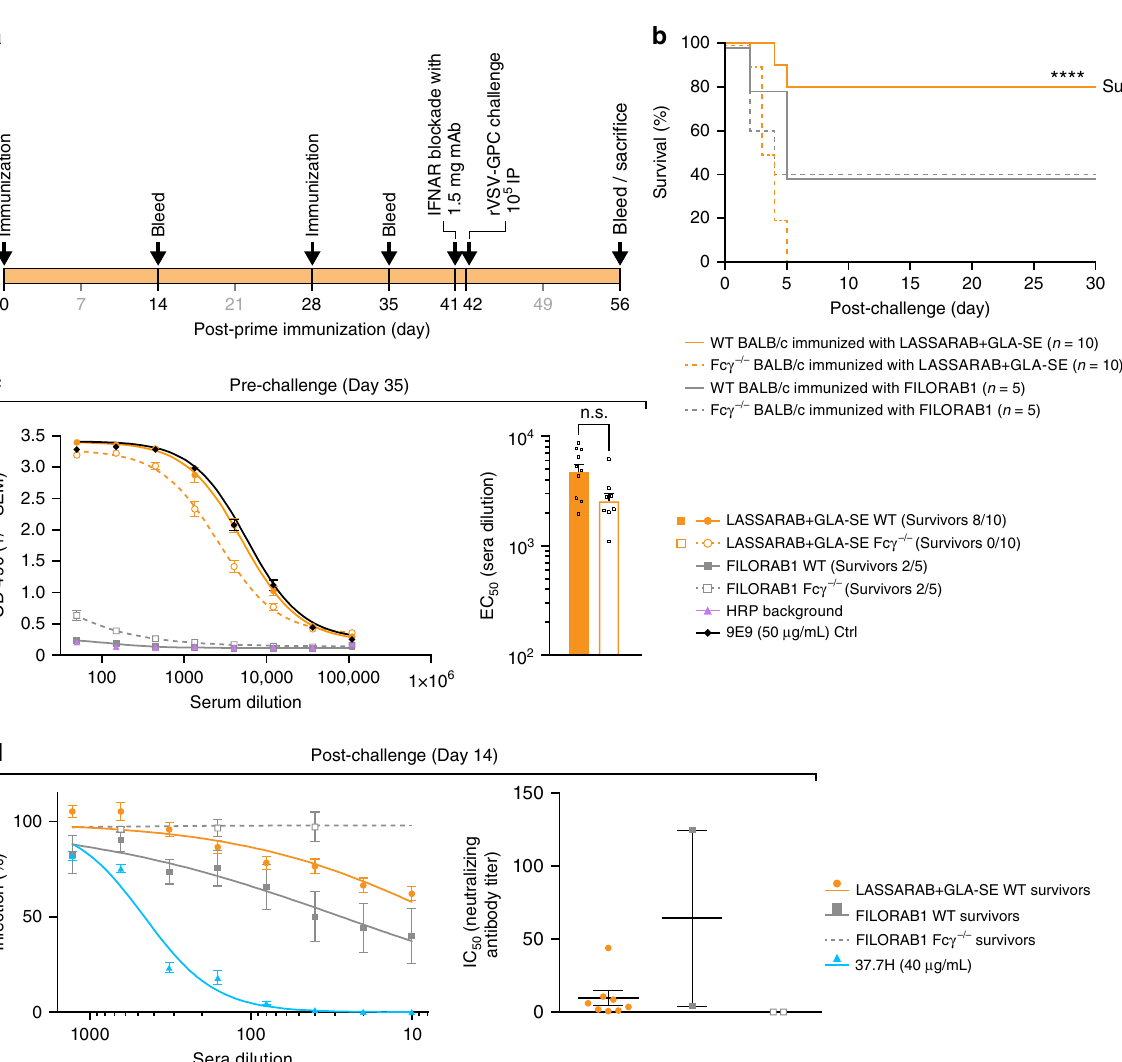
Fig. 8 Evaluation of in vivo relevance of non-NAbs LASV GPC speci fi c antibodies induced by LASSARAB + GLA-SE vaccination. a 8- to 10-week-old Balb/c (WT) or Balb/c with Fc γ chain KO (Fc γ − / − ) female mice were immunized with 10 µ g of inactivated particles of either LASSARAB or FILORAB1 (mock control) on day 0 and boosted on day 28. All four groups in total were adjuvanted with 5 µ g of GLA in a 2% SE with each vaccination. One day before exposure (day 41) animals were injected with 1.25 mg of anti-Ifnar mAb (MAR1-5A3, Leinco technologies) through intra-peritoneal injection (IP). On day 42, mice were exposed to 10 4 rVSV-GPC virus IP and general health (weights and clinical observation) was recorded until endpoint criteria were reached or end of study (supplemental). b Survival curves post-exposure of rVSV-GPC. Signi fi cance is compared between the WT LASSARAB vaccinated and the Fc γ − / − vaccinated using the log-rank (Mantel – Cox) test. c Pre-exposure total IgG titers anti LASV GPC were measured by ELISA on day 35 post-prime and ELISA curves were plotted according to OD490 reading value ( Y -axis) and serum dilution ( X -axis). On the right, EC 50 (half maximal effective concentration) of serum dilution of both LASSARAB groups (WT and Fc γ − / − ) is plotted on Y -axis on a log scale; statistical signi fi cance was calculated using one-way ANOVA. d Virus neutralization assay using pseudotyped VSV-GFP-NanoLuc with LASV GPC. On the right, percentage of cells infected is plotted against the serum dilution (survivors on day 14 post-exposure) of each respective group. On the right, the IC 50 (half maximal inhibitory concentration) of serum dilution is plotted individually and signi fi cance was calculated using one-way ANOVA. Error bars represent Standard Error Mean (SEM) and include all mice ( n = 10 per group [WT and KO] in LASSARAB and n = 5 per group [WT and KO] in FILORAB1 control) in pre-challenge and survivor mice in post-challenge. (**** P < 0.0001; *** P < 0.001; ** P < 0.01; * P <